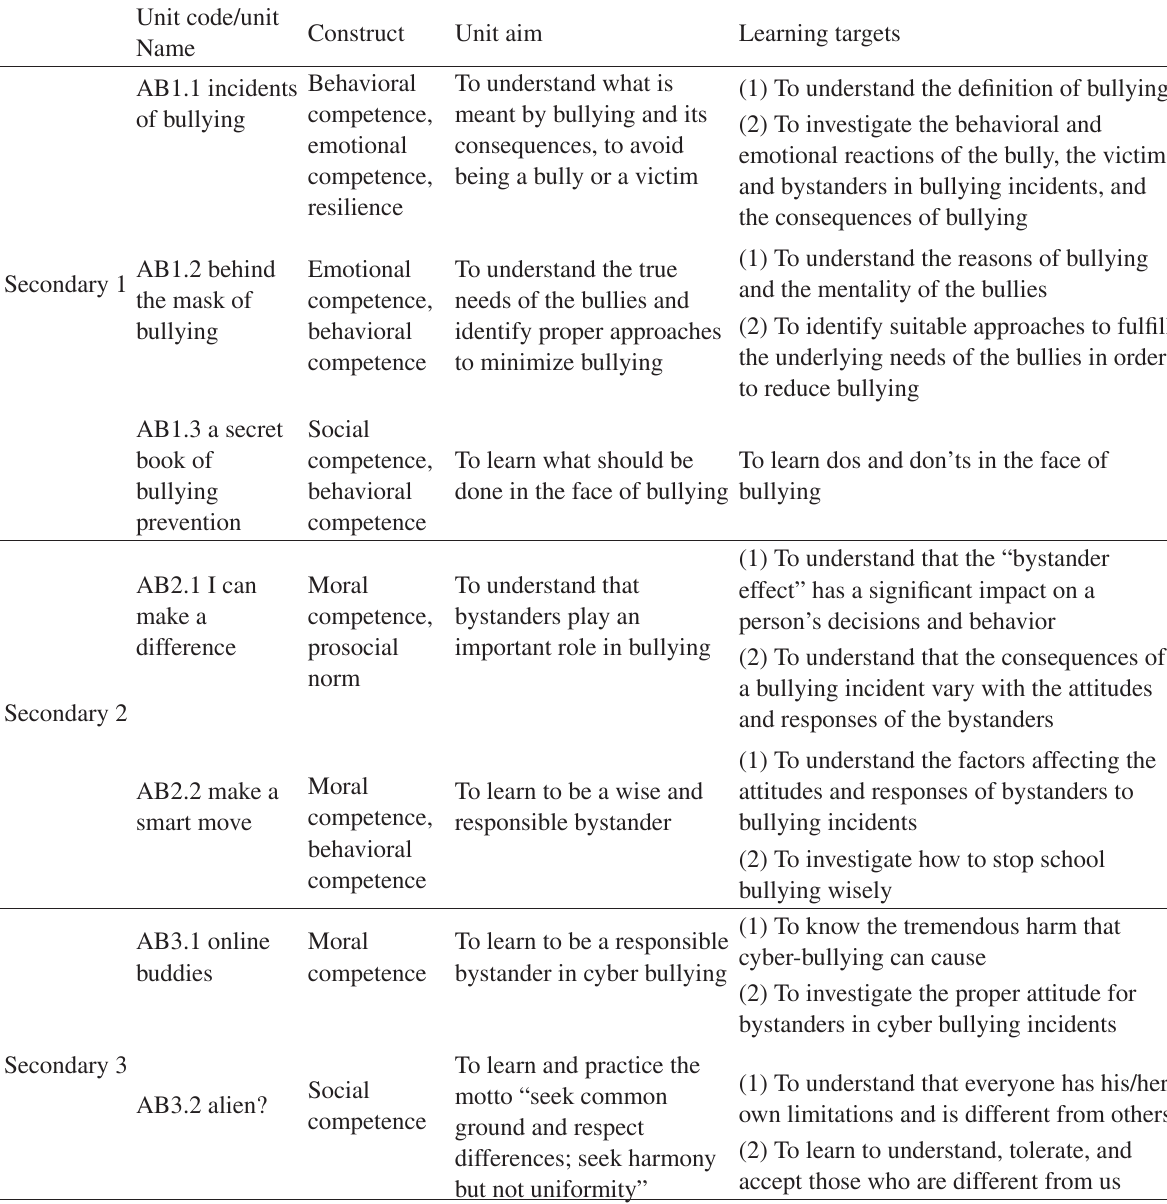
TABLE 1: Bullying units